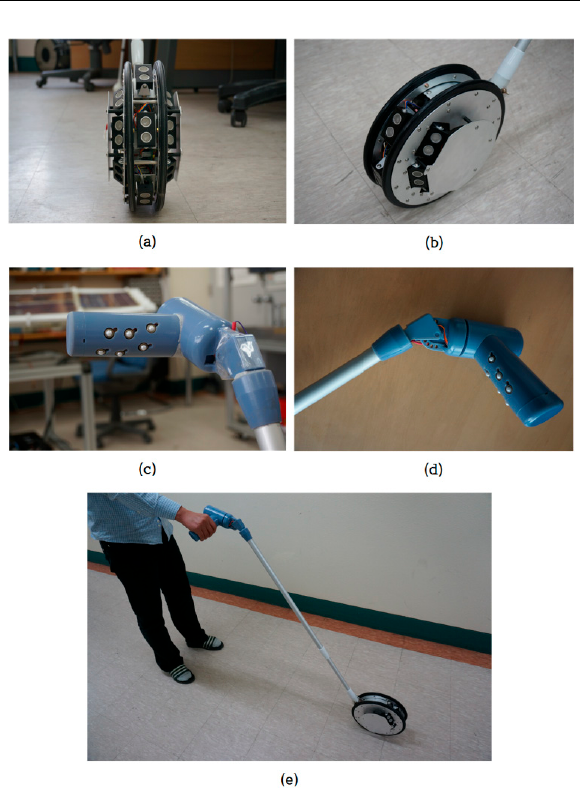
Figure 15. Assembled light-weight ETA with improved tactile display. ( a ) Front view; seven ultrasonic sensors are attached (2 × 3 for front and one for downward detection); ( b ) Side view; bearing-supported outer rim is rollable and the mechanism protects the sensors from an unexpected collision; ( c ) Implemented tactile display with 2 × 3 vibrotactile actuator to stimulate the corresponding fingers; ( d ) Grip-type tactile display enhances close contact of the user’s hand, and is adjustable to the posture of user’s hand; ( e ) User and the assembled